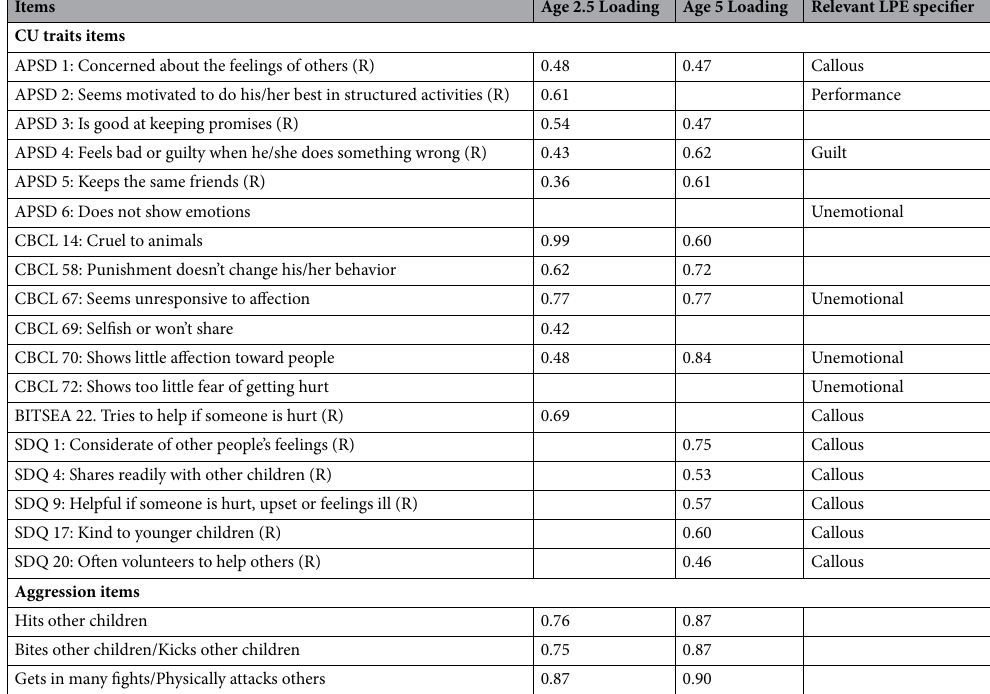
Table 1. Items with standardised factor loadings from the two-factor CU traits and aggression models at age 2.5 and 5.0 years and item relevance to the Limited Prosocial Emotions (LPE) specifier. CBCL =